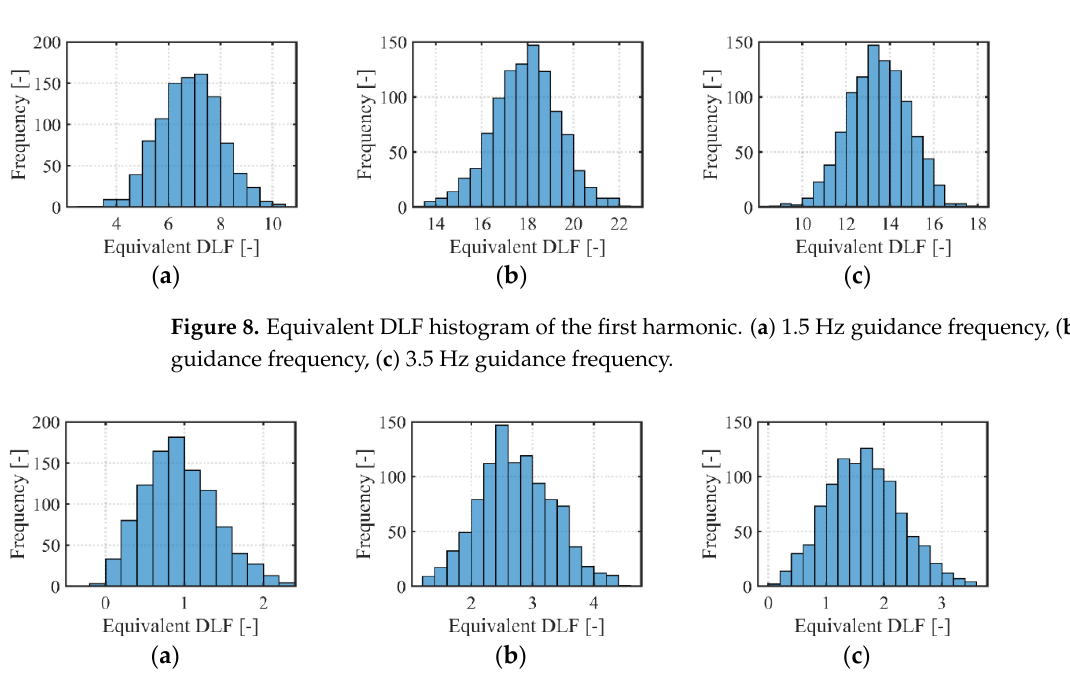
Figure 9. Equivalent DLF histogram of the second harmonic. ( a ) 1.5 Hz guidance frequency, ( b ) 2.5 Hz guidance frequency, ( c ) 3.5 Hz guidance